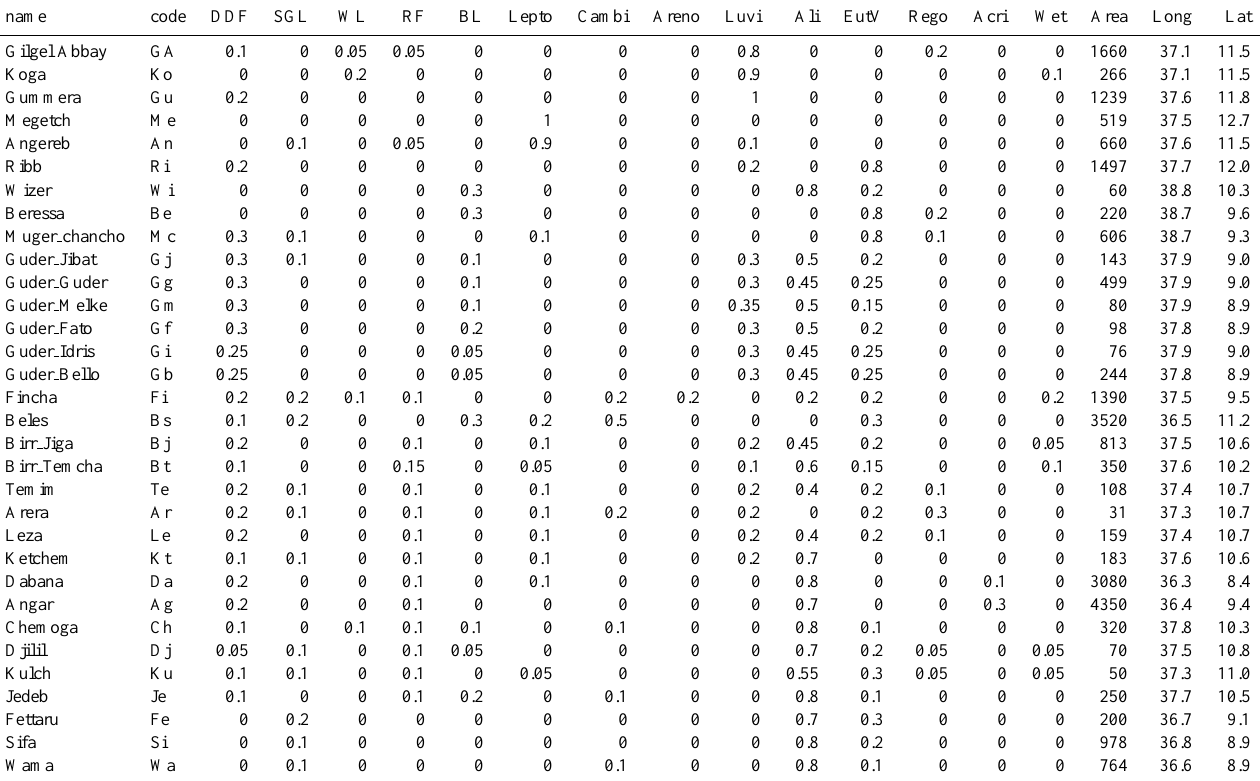
Meta metamorphic rock, Allu Alluvial, GL grazing land, CU cultivated land, OWL open woodland, DWF dense wet forest, DDF dense dry forest, SGL savannah grassland, WL woodland, BL (degraded) bush land, RF riverine forest, Lepto leptosols, Cambi cambisols, Rego regosols, Areno arenosols, Acri acrisols, Ali alisols, EutV Eutric Vertisols, Luvi luvisols, Wet Wetland, Area watershed area (km 2 ) , Long Longitude (degree-decimal), Lat Latitude